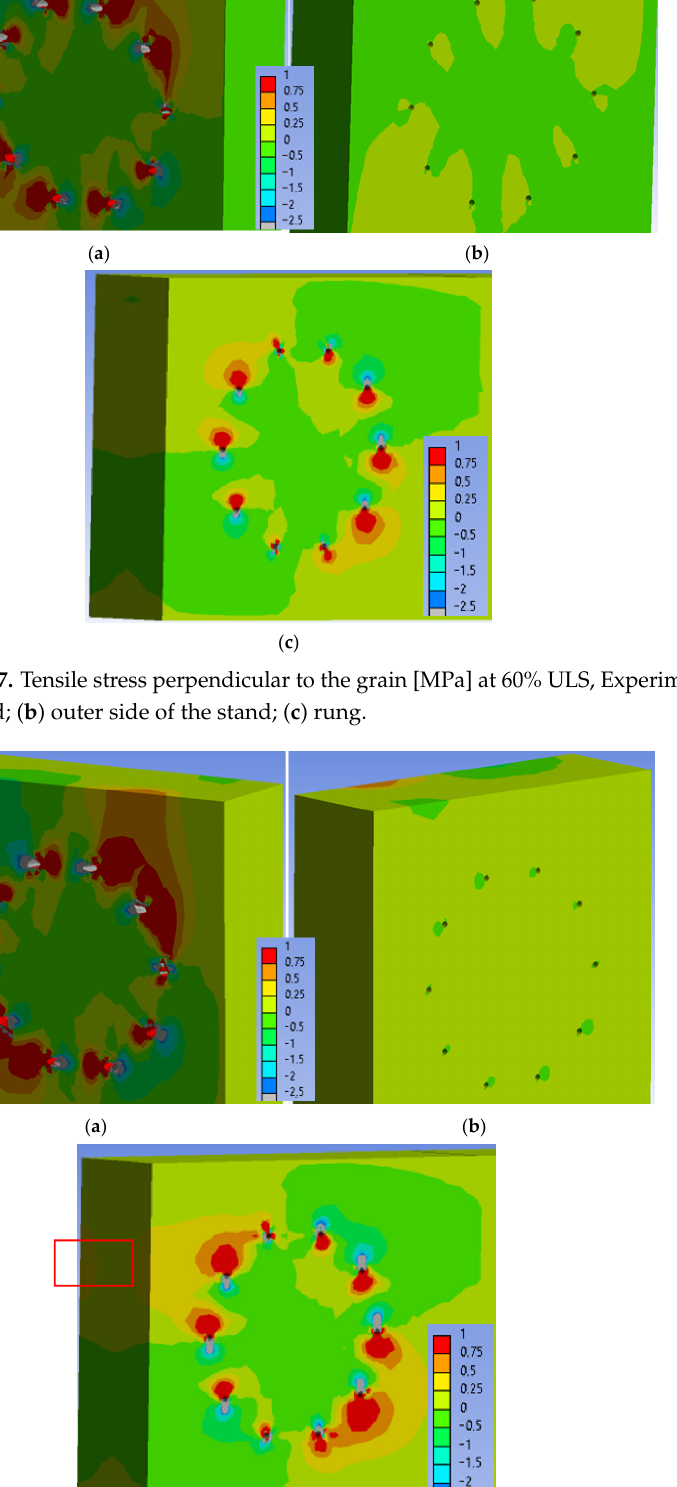
changed with values of 0.25–0.50 MPa. The area of this stress did not increase significantly.